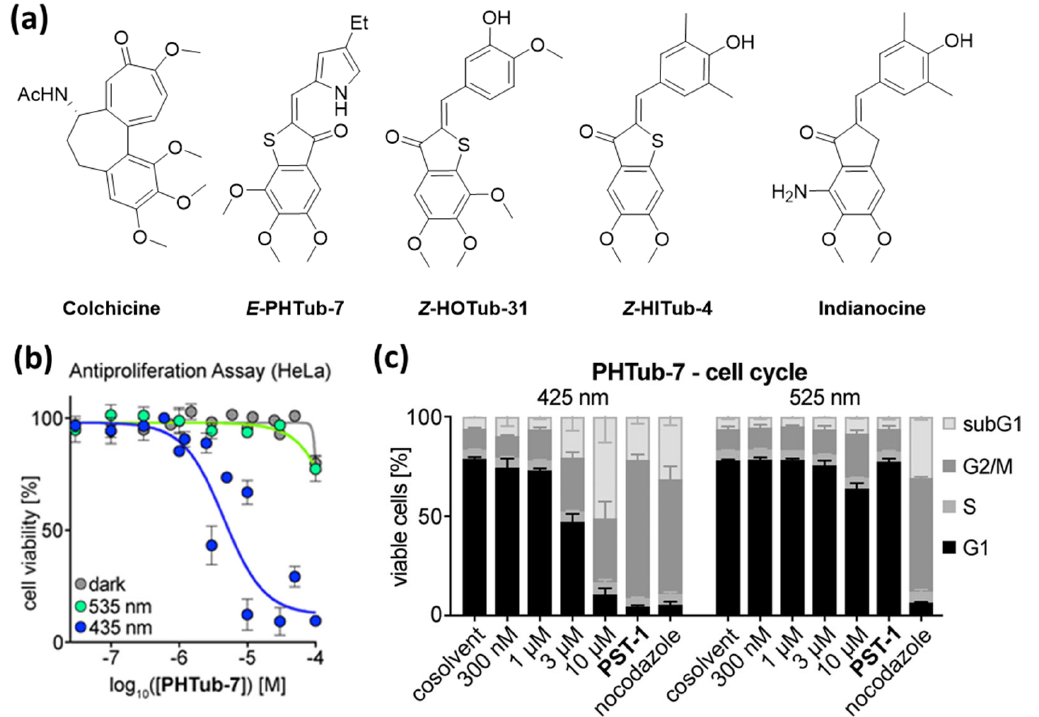
Figure 5. ( a ) The design of hemithioindigo-based photoswitchable microtubule destabilizing agents was based on colchicine and indianocine. ( b ) PHTub-7 shows light-dependent antiproliferative effects in cell viability assays. ( c ) Cell cycle analysis after treatment with PHTub-7 show significant G 2 /M arrest and cell death selectively under 425 nm but not under 525 nm irradiation. Reprinted with permission from the ref [44]. Copyright (2021) John Wiley and Sons.